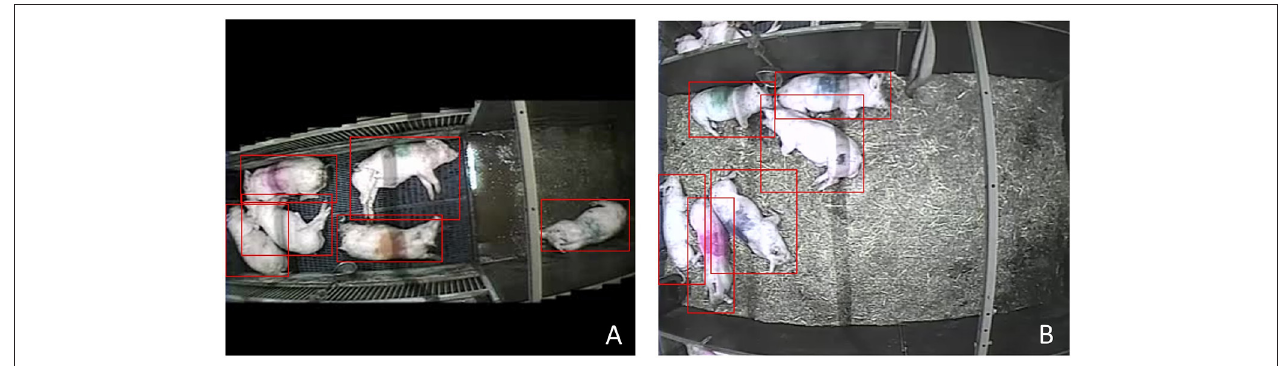
FIGURE 1 | Example frames with annotated bounding boxes (red boxes) in the barren (A) environment with blocked neighboring pens and the enriched (B) environment.